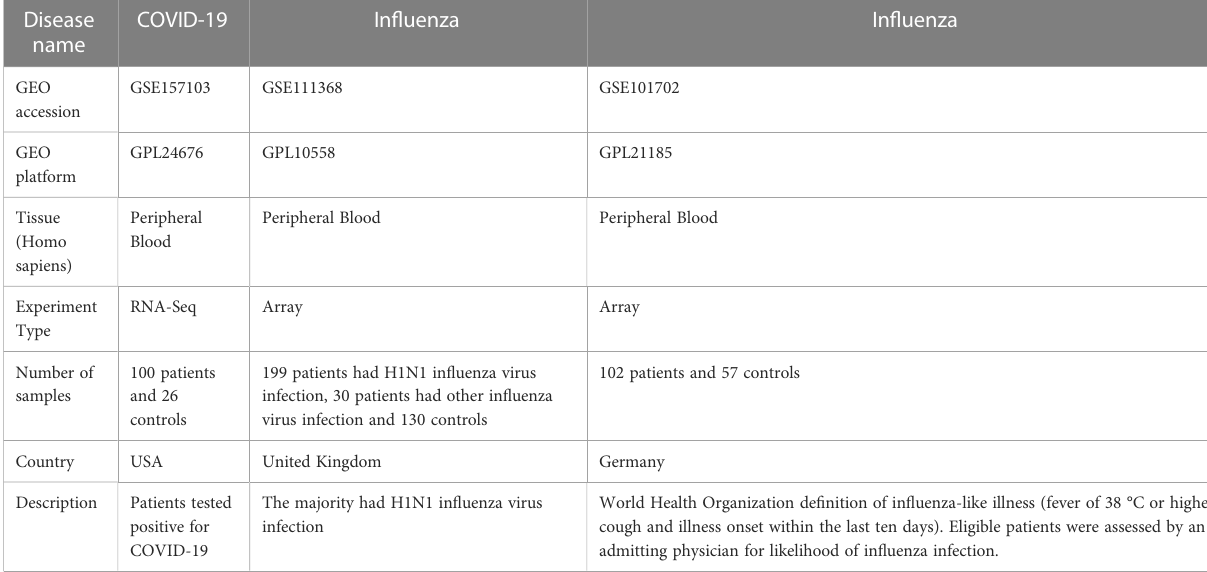
TABLE 1 Detailed information of selected datasets. Disease